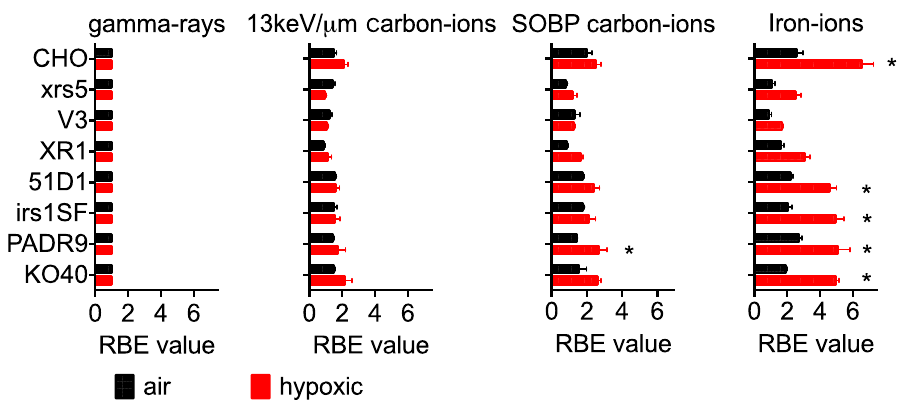
Figure 3. RBE values calculated from survival curves in different qualities of radiation. RBE values are the mean ± standard error of the means. * Indicates statistically significant differences between aerobic and hypoxic irradiation conditions ( p < 0.05).